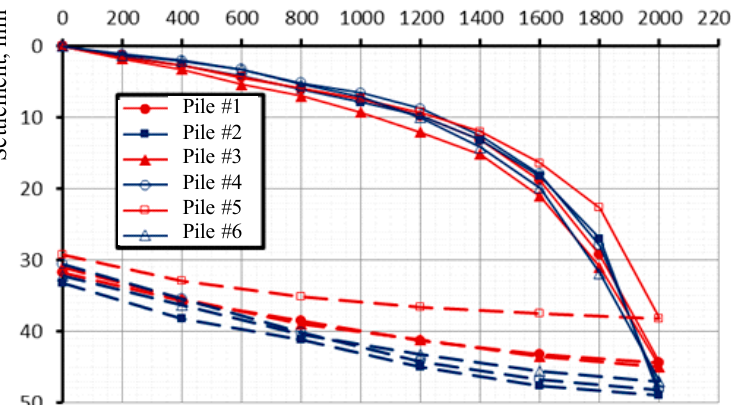
Figure 9. Correlation of loading P with settlement S according to the SLT results of the piles with a protective shell (with soil wetting).